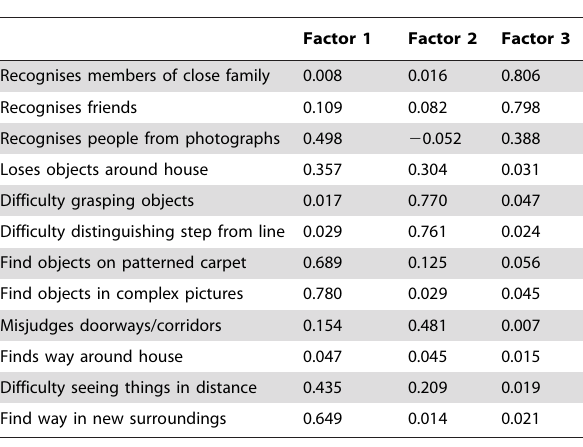
Table 1. Factor loadings (pearson correlation coefficients) between PCA-derived Visual Perception factors and the individual questions